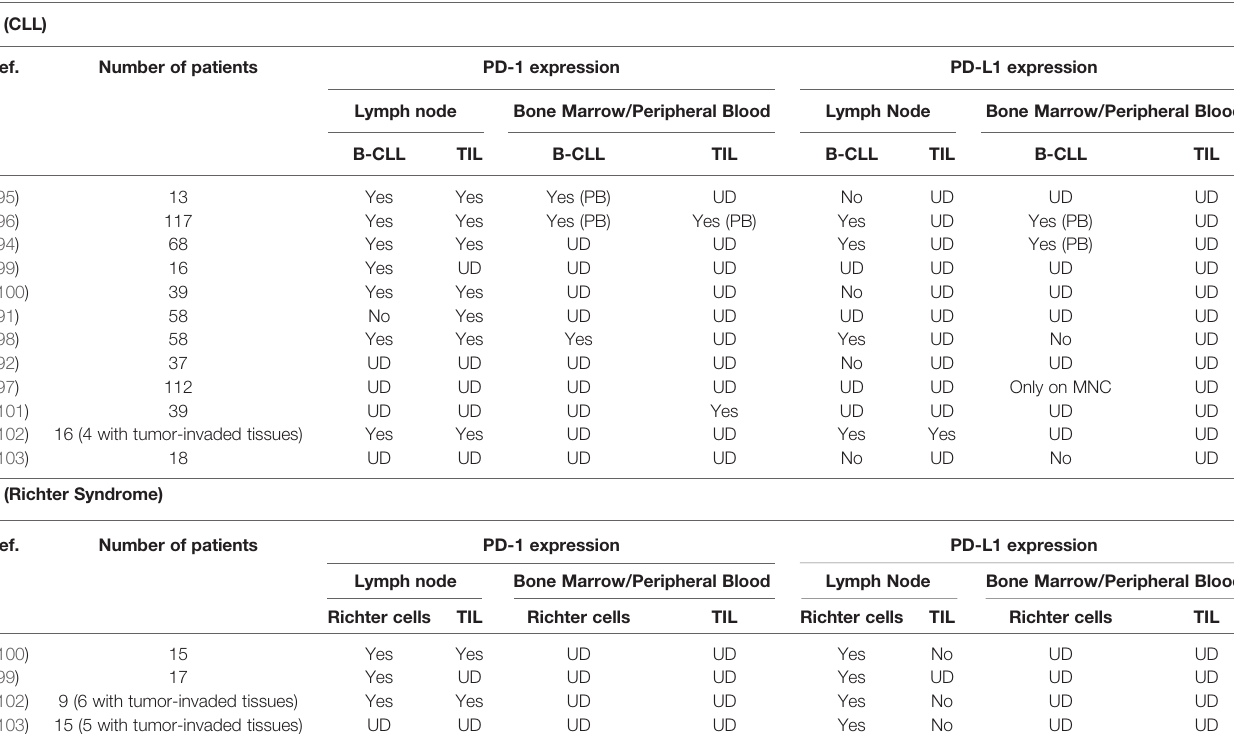
TABLE 1 | PD-1 and PD-L1 expression changes on malignant B-cells and tumor microenvironment TL surfaces, in CLL ( Table 1A ) or RS ( Table 1B ) context. A (CLL)